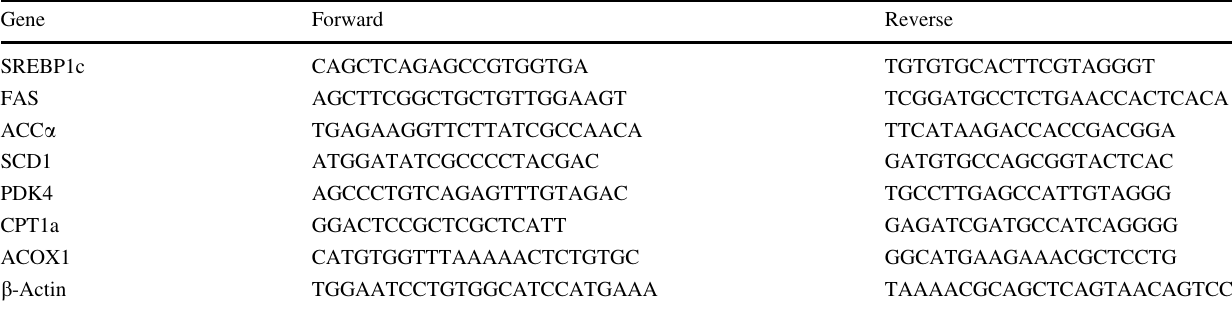
Table 1 Forward and reverse primers used for qPCR